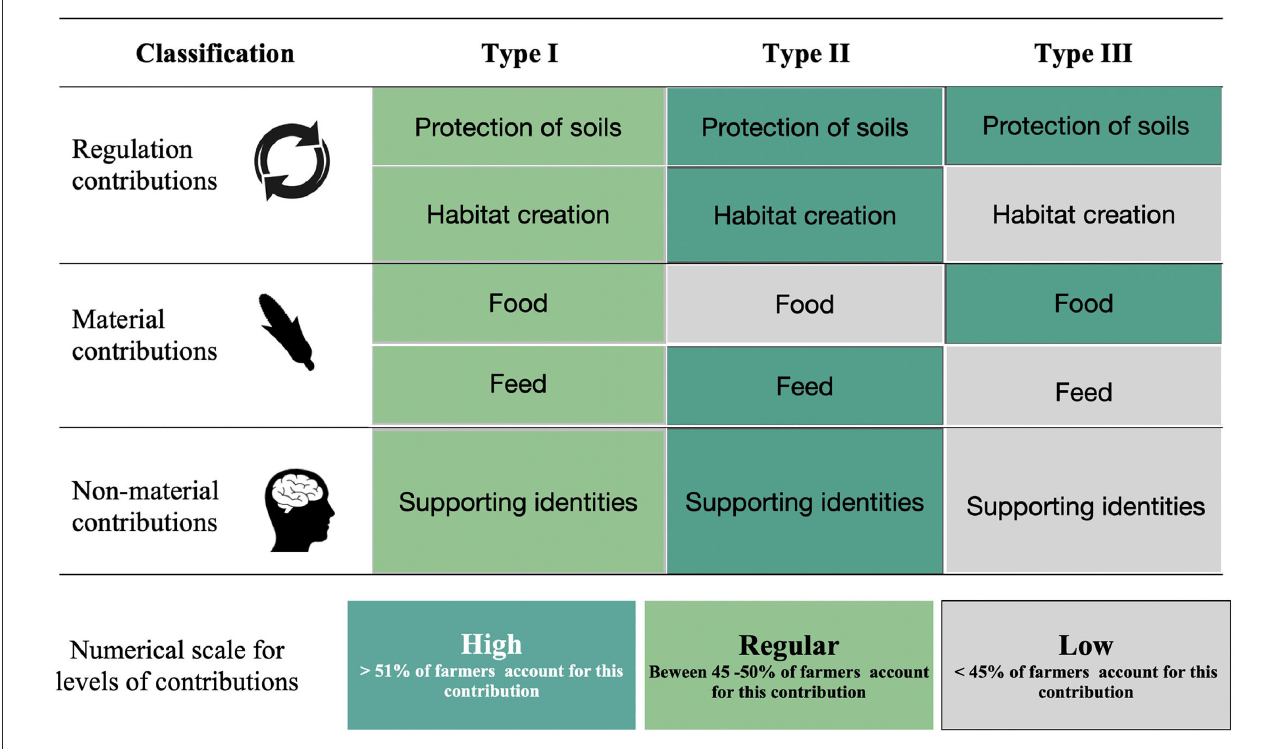
FIGURE6 Nature’s contributions in maize agroecosystem from Mexico highlands. The shades of gray show the level of contribution in the management types, the dark gray means a high level of contribution, light gray means a regular level of contribution, and white means a low level of